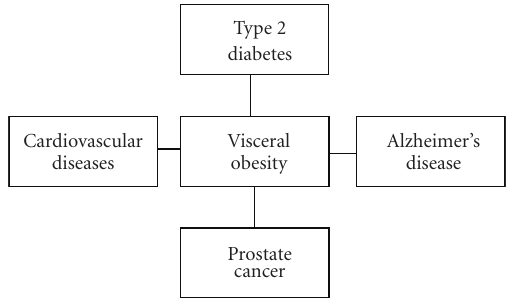
Figure 1: A common yet preventable risk factor for these multi- factorial age-related diseases is the visceral obesity. Metabolic syn- drome is also associated with obesity. It assembles some abnormal- ities, including insulin resistance, hyperinsulinemia, hypertension, and dysplipidemia, all risk factors directly associated with both type 2 diabetes and cardiovascular